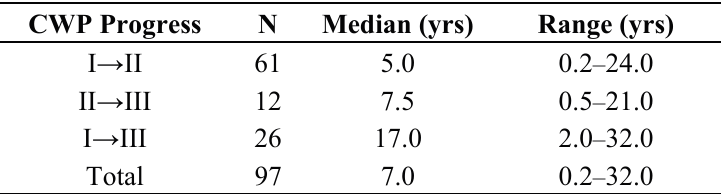
Table 4. The duration of CWP